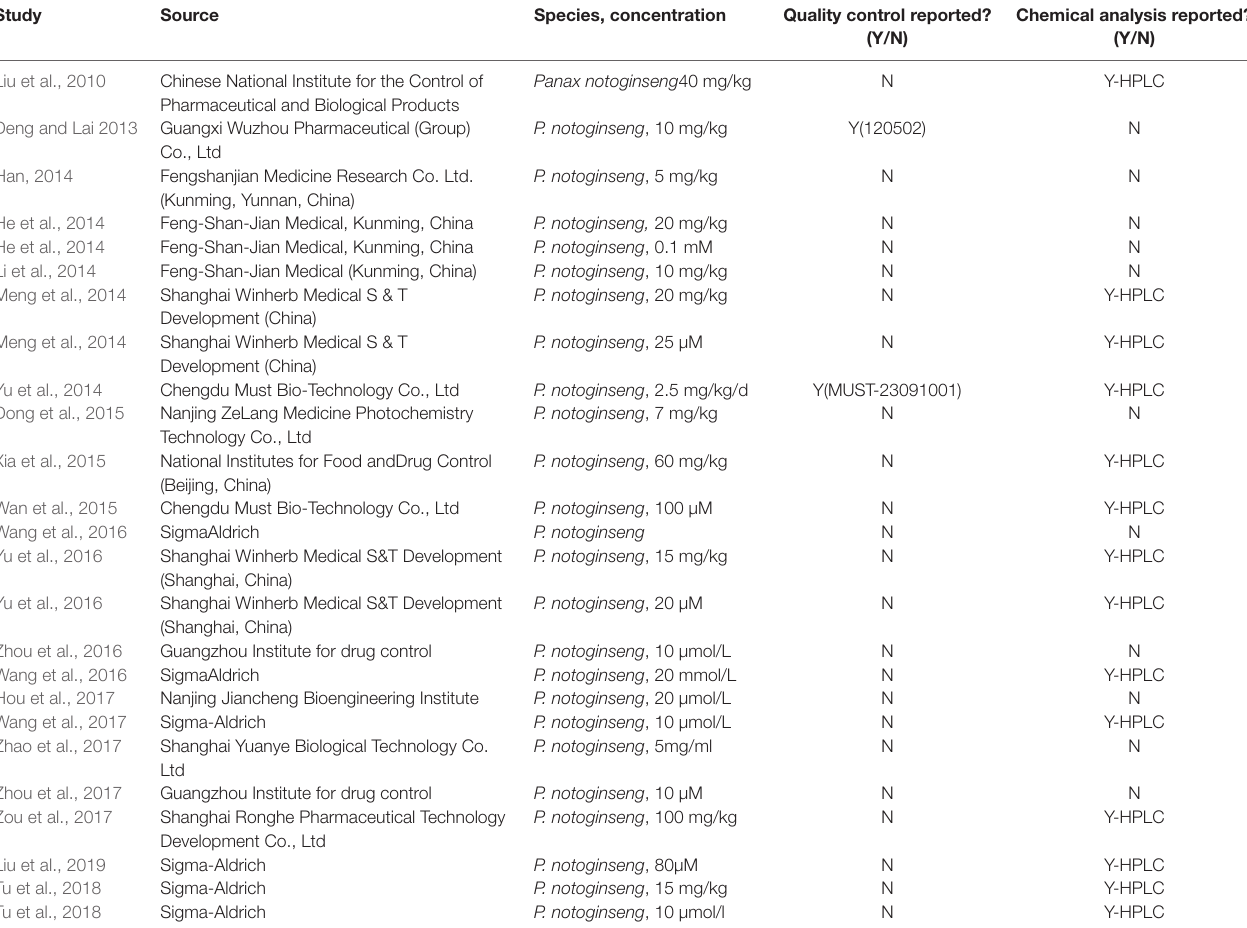
TABLe 3 | Statement of the characteristics of